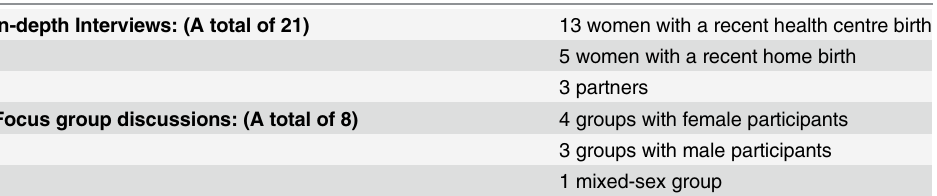
Table 1. Overview of IDIs and